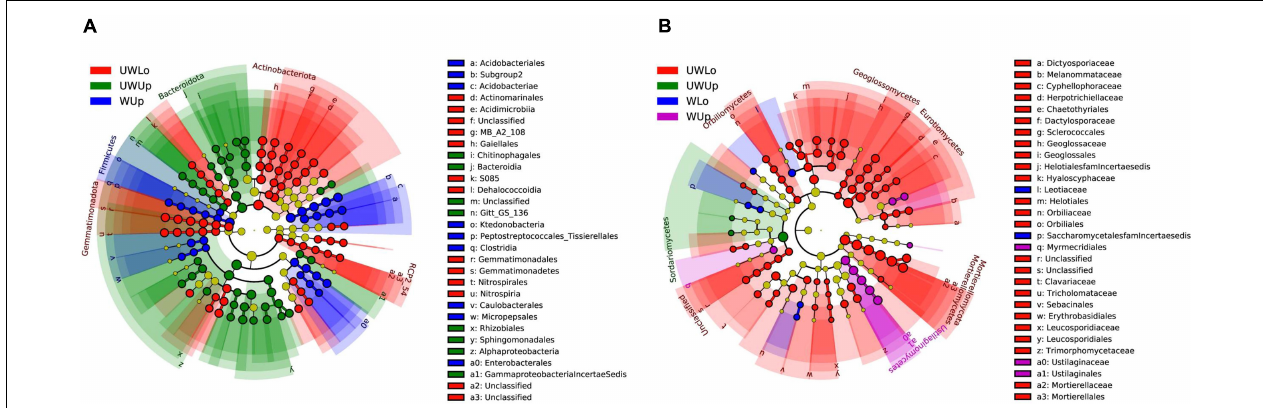
FIGURE 1 | Linear discriminant analysis effect size (LEfSe) analysis identified the most differentially abundant taxa among treatments ( p < 0.05; LDA score 3.0) based on 16S rRNA gene amplicon sequences (A) and ITS gene amplicon sequences (B) . Differences are represented in the color of the most abundant class, while no significant difference is indicated by yellow. The diameter of each circle is proportional to the abundance of the taxon, representing the kingdom, phylum, class, order, family, genus, and species. UWUp, unwarming upper; UWLo, unwarming lower; WUp, warming upper; WLo, warming lower.